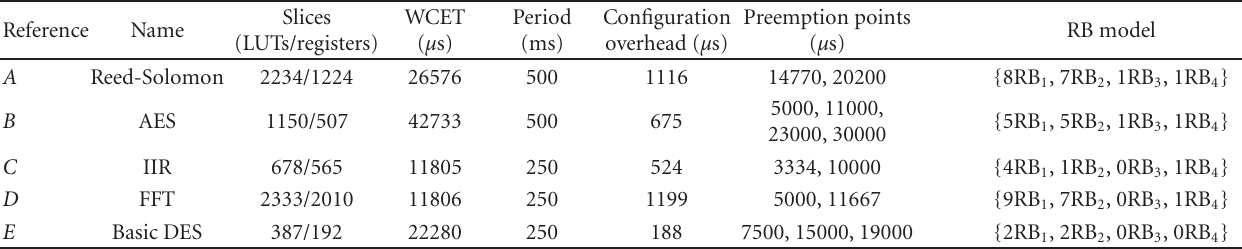
Table 2: Task features.